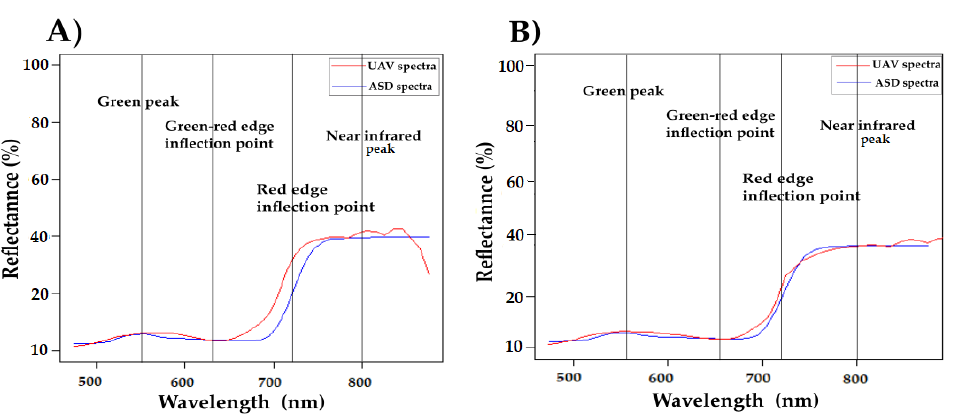
Figure 2. Comparison of the canopy reflectance between spectra derived from a field spectrometer (ASD FieldSpec3, blue) and UAV spectra (red) before ( A ) and after ( B ) correction of spectral band positions for a representative plot (LAI = 2.04 m 2 /m 2 , fCover = 0.65, and CCC = 1.44 g/m 2 ) on 19